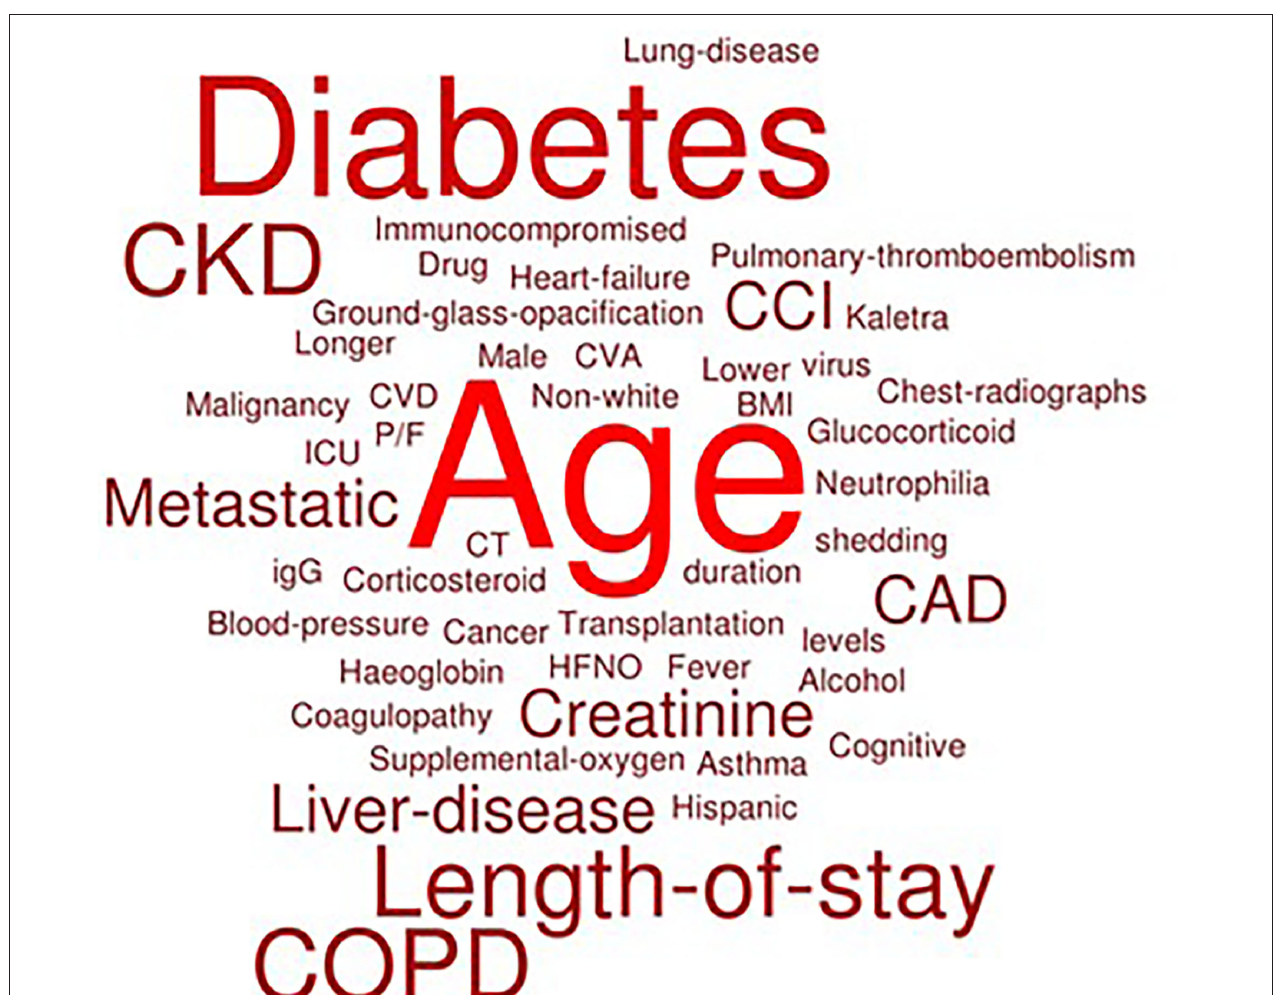
FIGURE 2 | Word cloud for the risk factors of